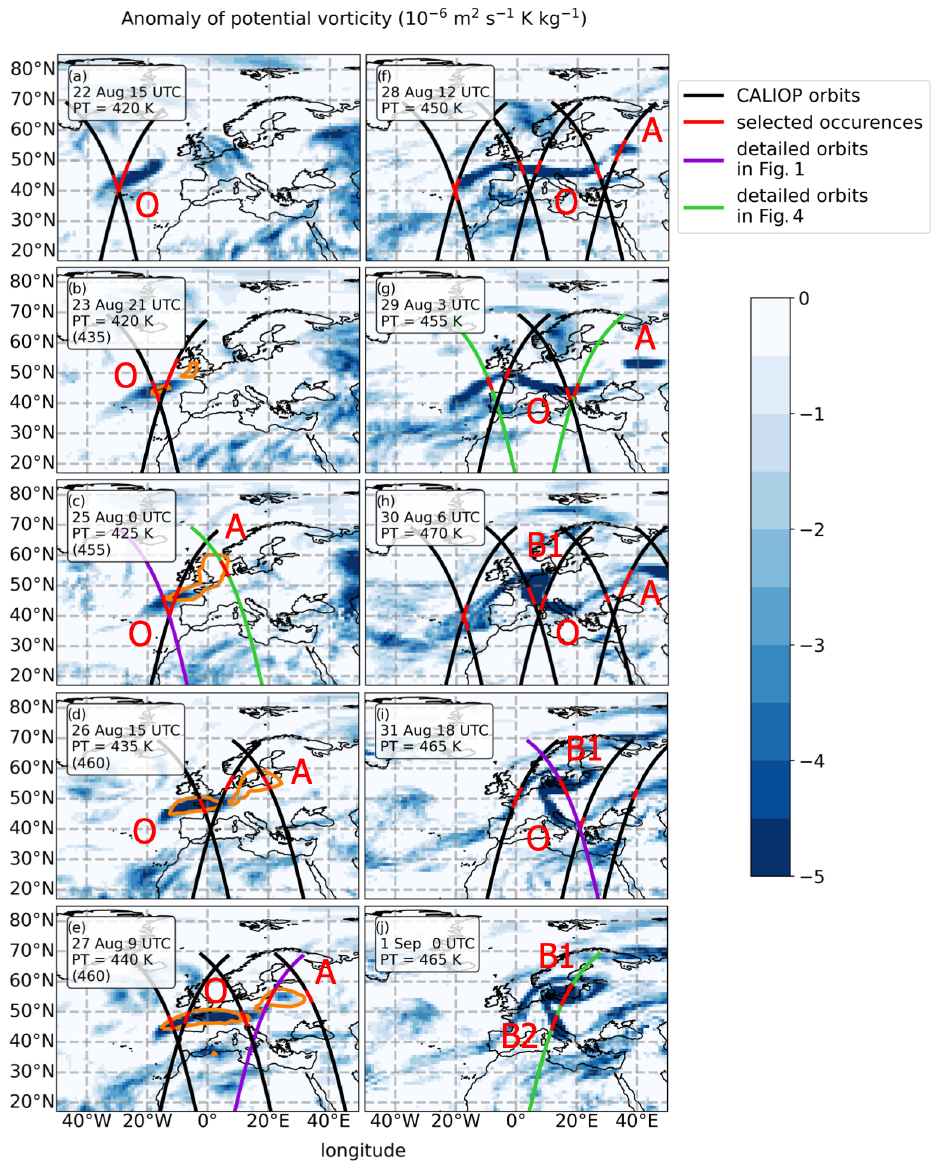
Figure 3. Sequence of PV charts showing the splitting of vortex O into vortices A, B1 and B2. The map is plotted on the potential temperature surface corresponding to the core of vortex O or its continuation B2 in the ERA5 tracking. The orange lines are plotted at the isentropic level of vortex A, specified within parenthesis, and show the contour of − 2PVU (1 PVU = 10 − 6 Km 2 kg − 1 s − 1 ) for vortex A. The black, green and purple lines show the intersecting orbits of CALIPSO, and the red segments show the parts of the orbits occupied by the bubble (only the bubble core extent is displayed here). The maps are plotted at the hour that best matches the selected CALIOP occurrences. The purple orbits are those corresponding to the sections shown in Fig. 1; the green orbits are those corresponding to the sections shown in Fig. 4. Daytime and night-time orbits are used: the daytime orbits run from south-east to north-west, whereas the night-time orbits run from north-east to south-west. Starting from 1 September, the remainder of vortex O is relabelled as